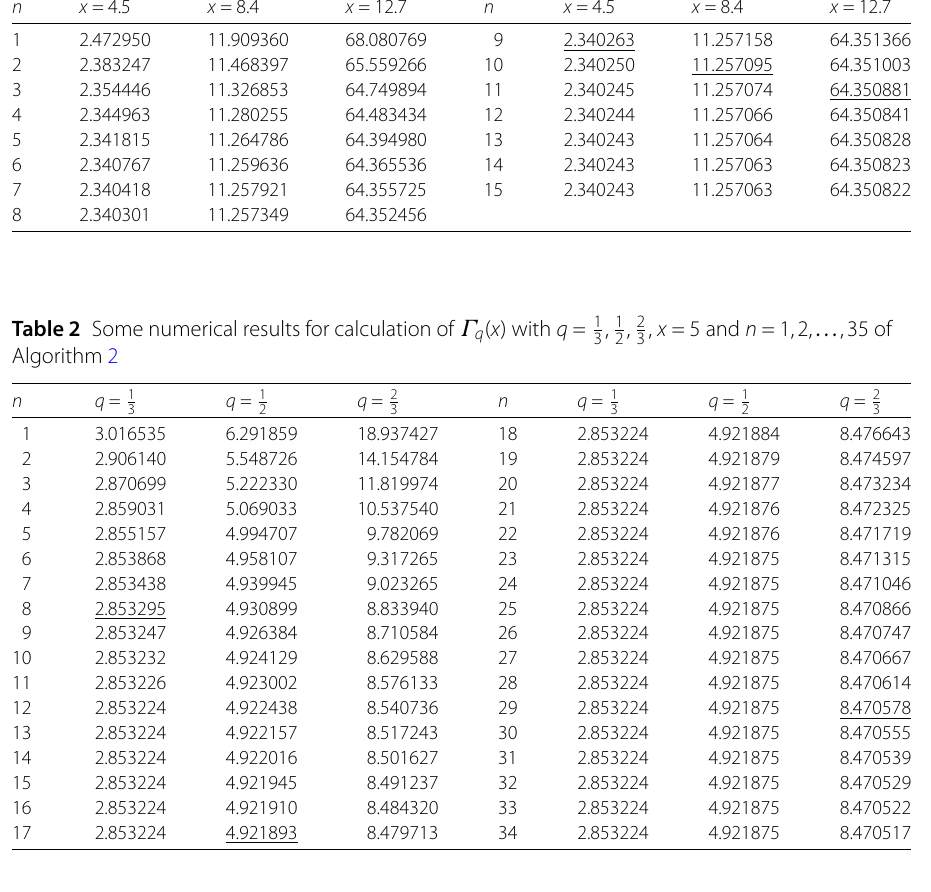
Table 3 Some numerical results for calculation of Γ q ( x ) with x = 8.4, q = 1